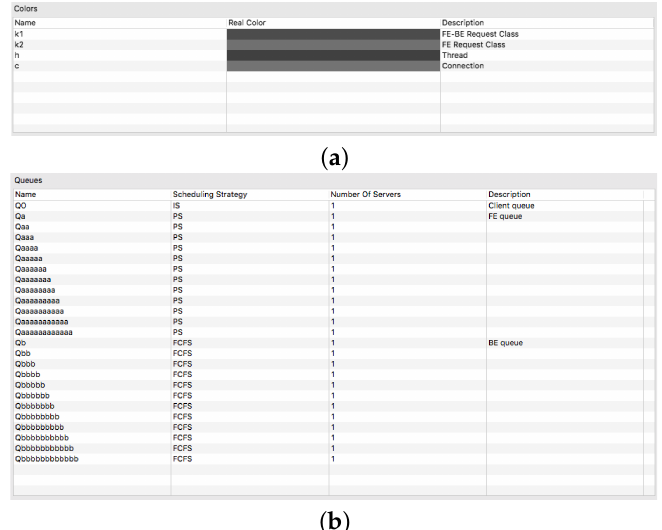
Figure 4. QPME tool configuration: ( a ) token colors, ( b ) example